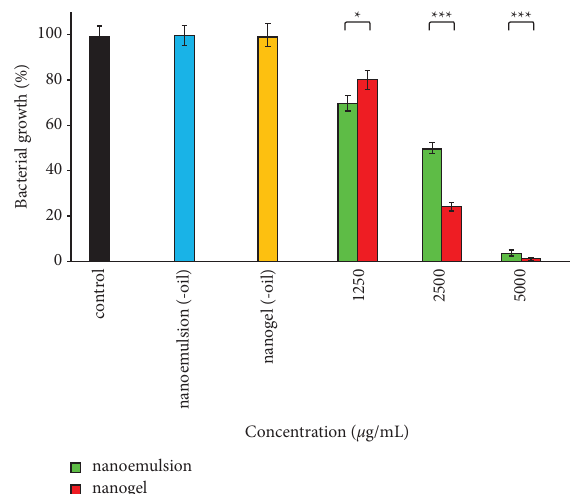
Figure 6: Antibacterial impacts of the nanoemulsion and nanogel containing C . cyminum EO against P . aeruginosa ; ∗ P < 0 . 05 and ∗∗∗ P < 0 .